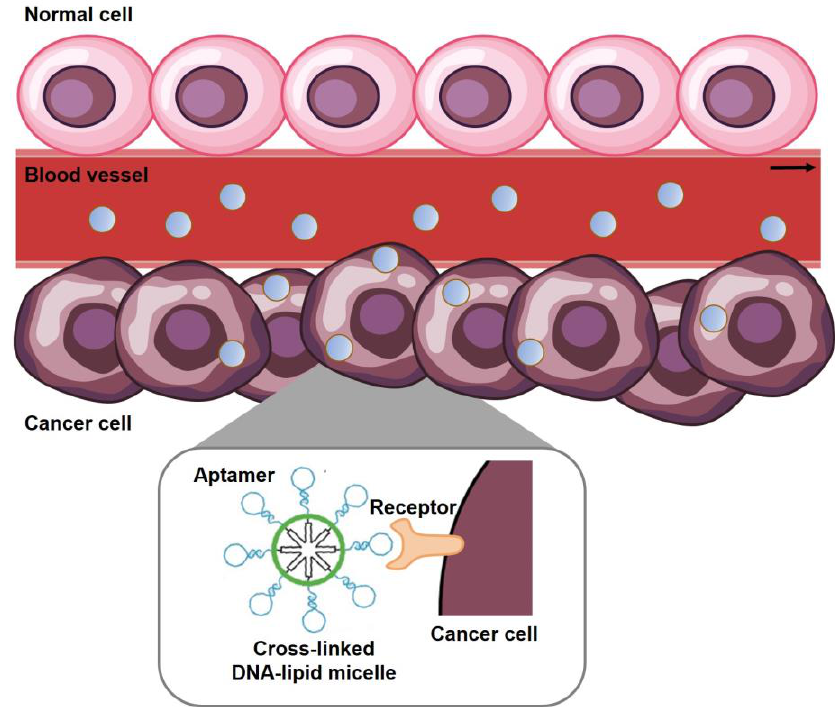
Figure 5. Schematic illustration shows the aptamer-nucleic acid micelle targeting cancer cells through aptamer-receptor recognition (reproduced from ref. [52]).